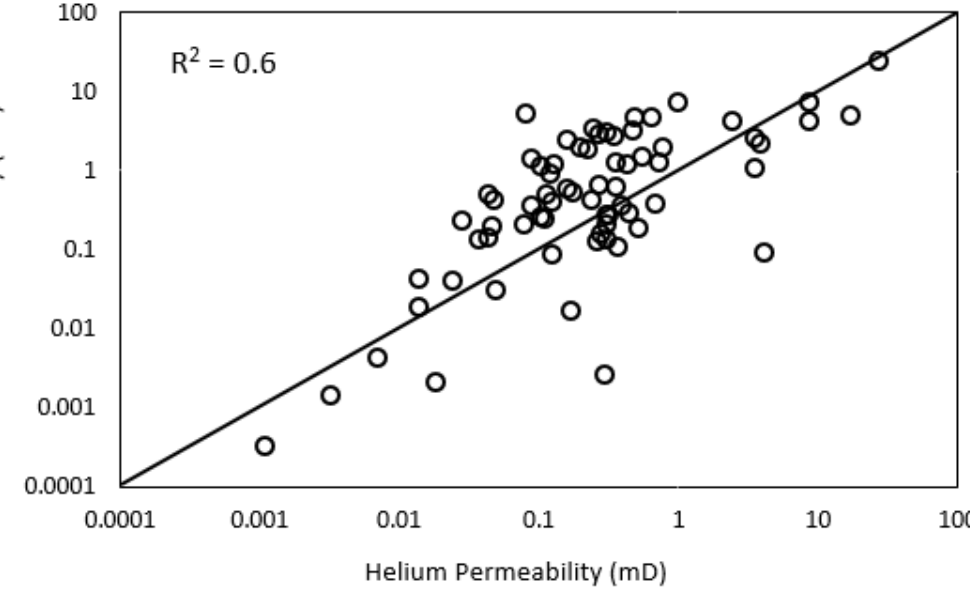
Figure 15. Cross-plot of helium porosity and gravimetric porosity for 56 subsamples.